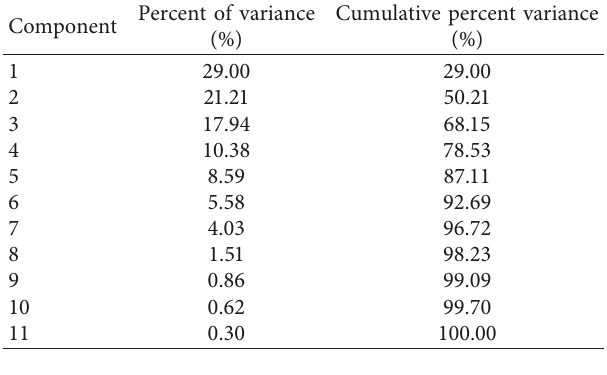
Table 3: Variance of principal